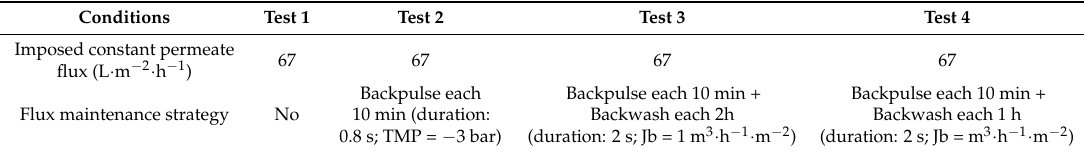
Table 3. Permeate flux and flux maintenance strategies applied in the different filtration